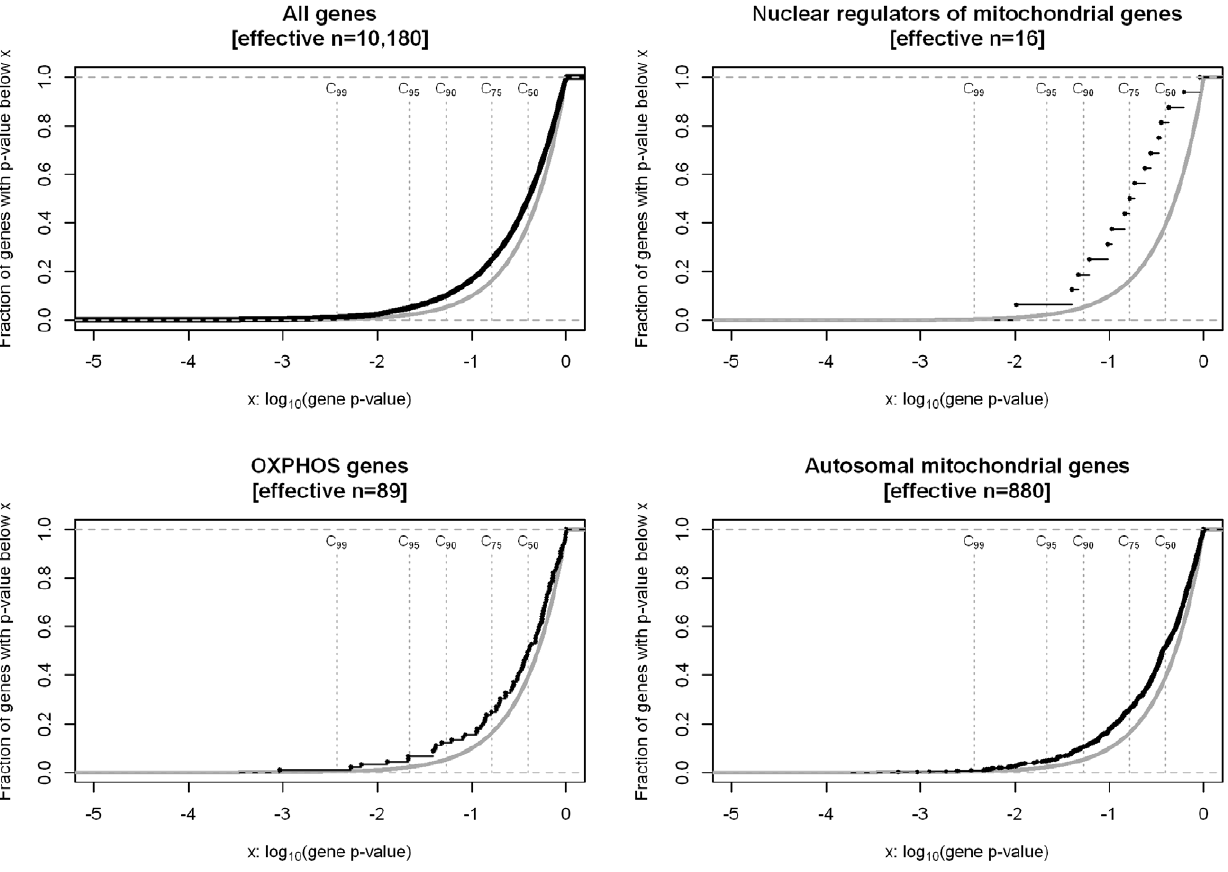
Figure 1. Empirical cumulative distribution functions (ECDF) of P g in four different gene sets in the Discovery. A case-control GWAS sample of 453 (extremely) obese cases and 435 lean controls was analyzed. In each panel the grey line represents the ECDF of the uniform distribution (null hypotheses of no association) and the black line represents the ECDF of the respective gene set. P g , gene-wise corrected p-value.